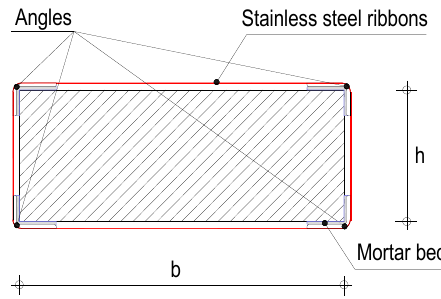
Figure 1. Typical configuration of jacketing interventions with the CAM technique.